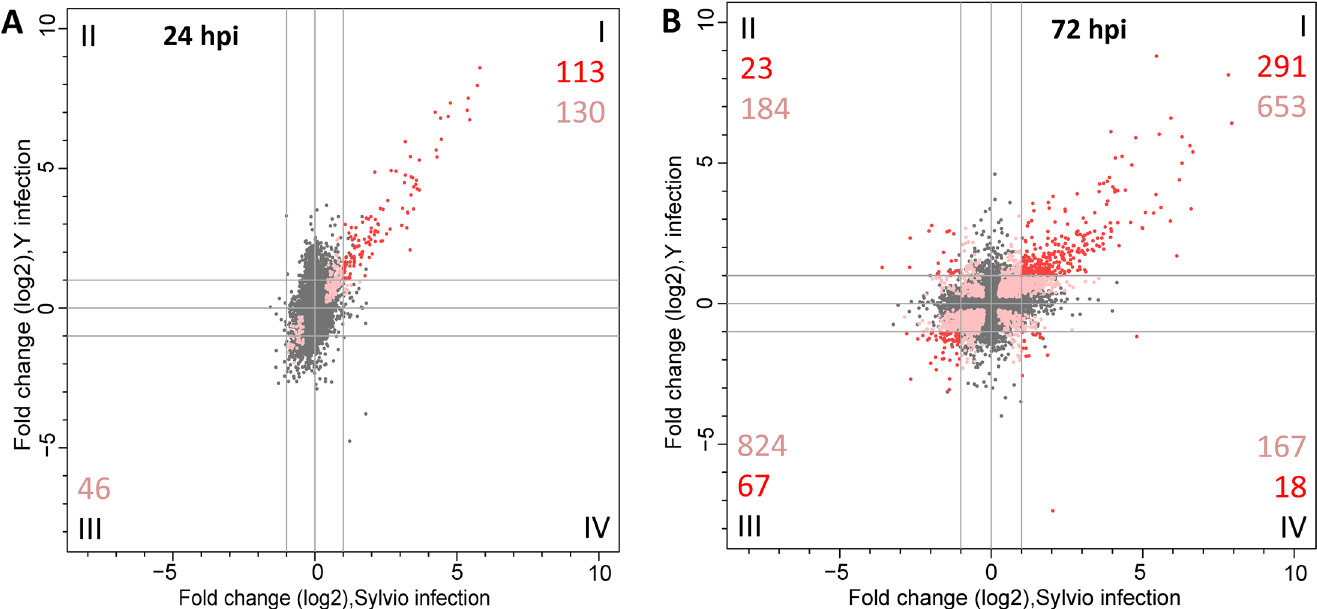
Fig 3. Comparative analysis of the host transcriptome response to infection with Sylvio versus Y strain. Scatterplot of log 2 fold change in expression of human genes in HFF cells infected with Sylvio (x-axis) versus Y (y-axis) at 24 hpi ( A ) and 72 hpi ( B ). Genes that were not significantly differentially expressed are shown as gray dots. Pink dots represent significantly DE genes in infections with both strains but had log 2 FC in one or both strains that was below our cutoff value of 1. Red dots depict genes that were significantly DE and had absolute value of log 2 FC > 1 in both strains. The numbers in each quadrant correspond to the total number of significantly DE genes that met the log2 FC cutoff of 1 (red) or were significantly DE but did not meet the FC cutoff (pink).